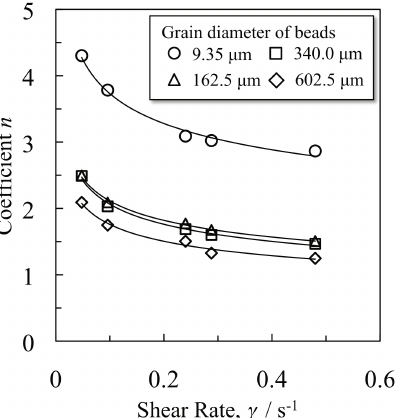
Figure 5. Relationship between the coefficient n and the shear rate.